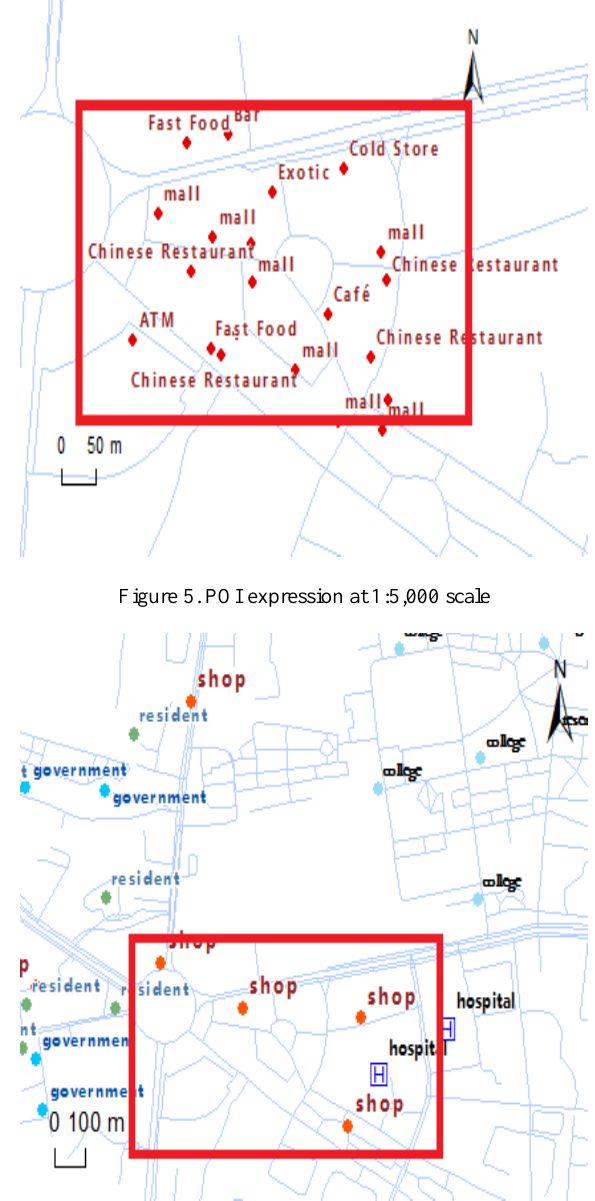
Figure 6. POI expression at 1:10,000